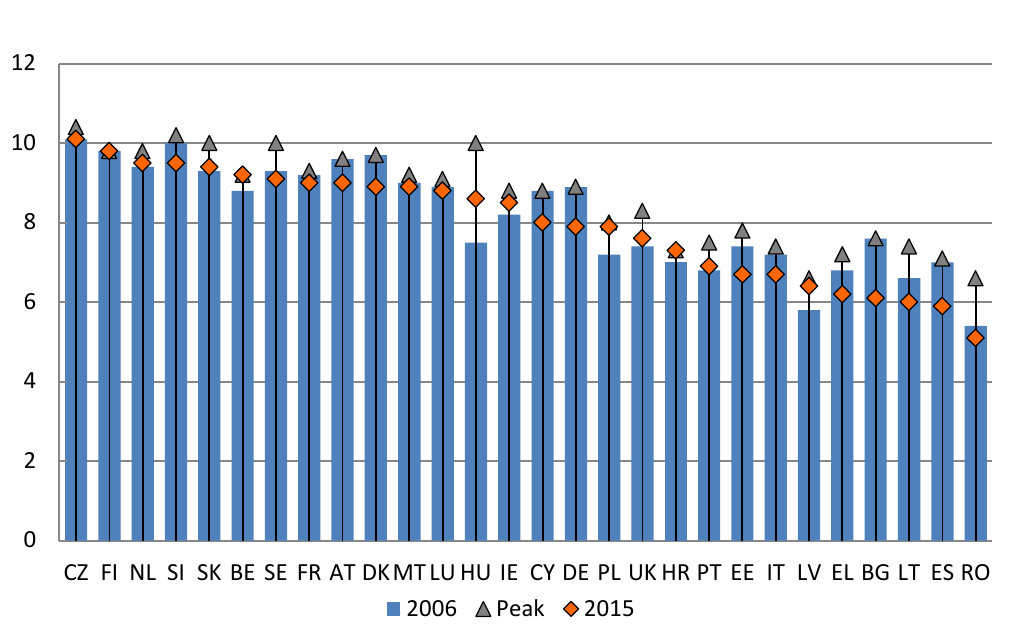
Figure 2. Income share by the first two deciles in the EU-28 countries (2006, 2015, and period peak). Source: Own elaboration based on statistics from Eurostat. Notes: (i) Countries appear ranked according to the highest income share of the poorest 20% in 2015. (ii) Croatia's data correspond to 2010 instead of 2006; Romania's data correspond to 2007 instead of